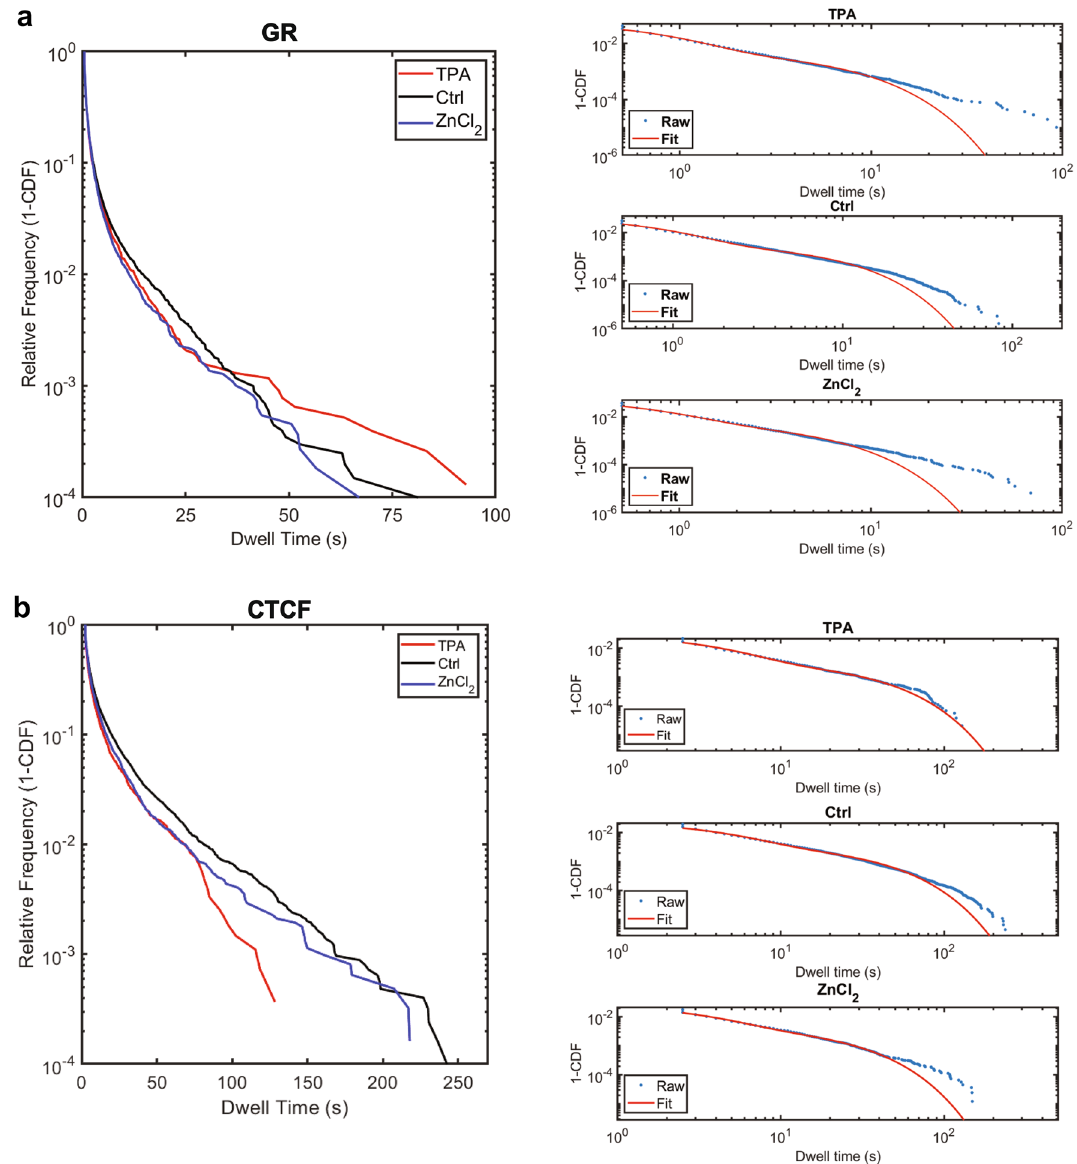
Figure 4. The effect of Zn 2+ on dwell times, as measured by HILO . ( a ) Left: Raw 2D dwell time survival curves (1-CDF) for HaloTag-GR cells treated with 50 µM TPA (red), 30 µM ZnCl 2 (blue), or a media-only control (black). Right: photobleaching-corrected survival curves for each treatment & their respective biexponential decay fits. ( b ) same as in ( a ), but with HaloTag-CTCF cells.